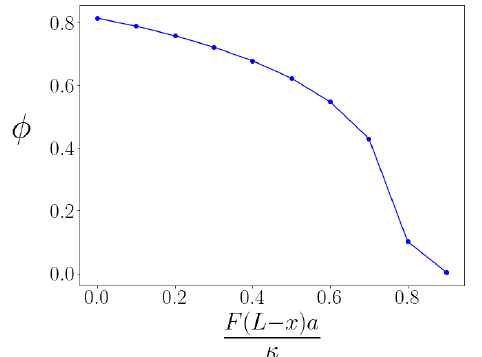
Figure 3. Angle produced by braid under extension as a function of the value of the torque. Dimen- sionless parameter ζ = 4. The angle versus torque curve shows that the bending response of the braid is nonlinear, unlike the linear or Hookean response of the individual